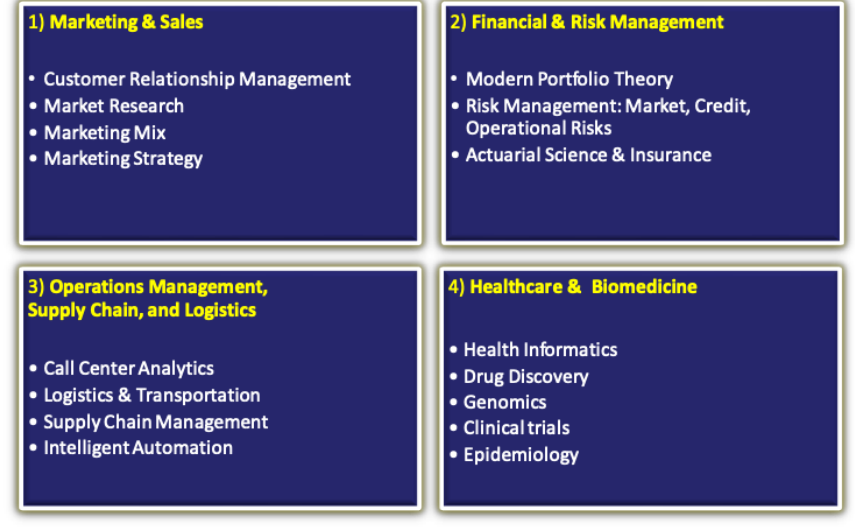
Figure 7. Common Data Science